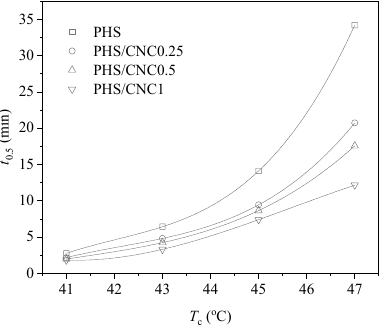
Figure 6. Plots of t 0.5 versus T c for PHS and PHS/CNC composites.